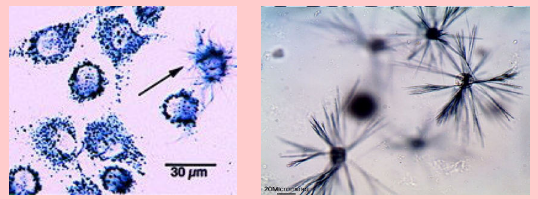
Six groups of N2a cells were used as per the following protocol: Untreated control (no drug), 20 µM